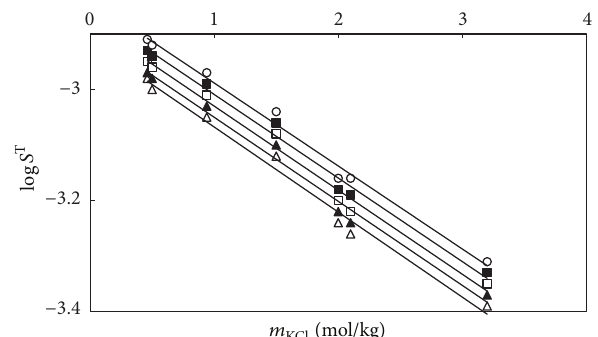
Figure 2: Dependence of the total solubility on ionic strength in KCl, for 1,5-dihydroxynaphthalene at 293.15 K ( 󳵻 ), 298.15 K ( 󳵳 ),